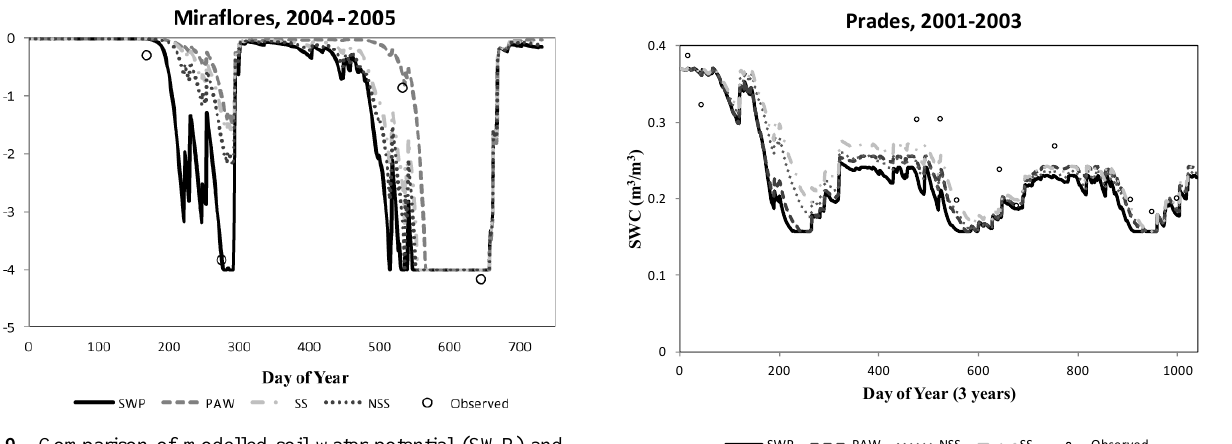
Fig. 9. Comparison of modelled soil water potential (SWP) and observed pre-dawn leaf water potential in 2004 and 2005 for a holm oak stand at Miraflores de la Sierra using four methods that relate soil water to g sto (see methods section for details).